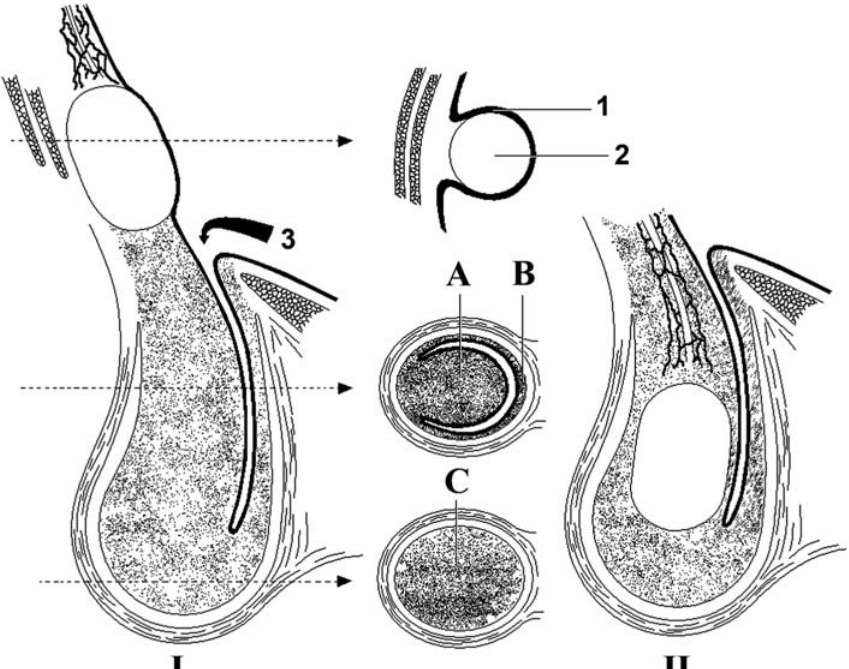
Figure 5 – Schematic illustration of the anatomical associations between testis, gubernaculum and peritoneum before (I) and after (II) the descent of the testis. A = plica gubernaculi, B = Pars vaginalis gubernaculi, C = Pars infravaginalis gubernaculi, 1 = peritoneum, 2 = gonad, 3 = processus